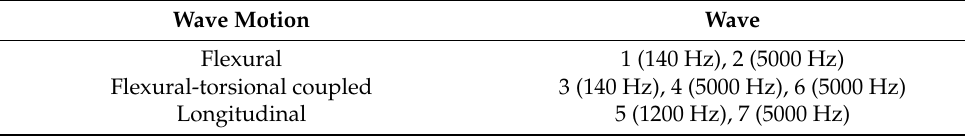
Table 1. Three wave motions in Figure 5.